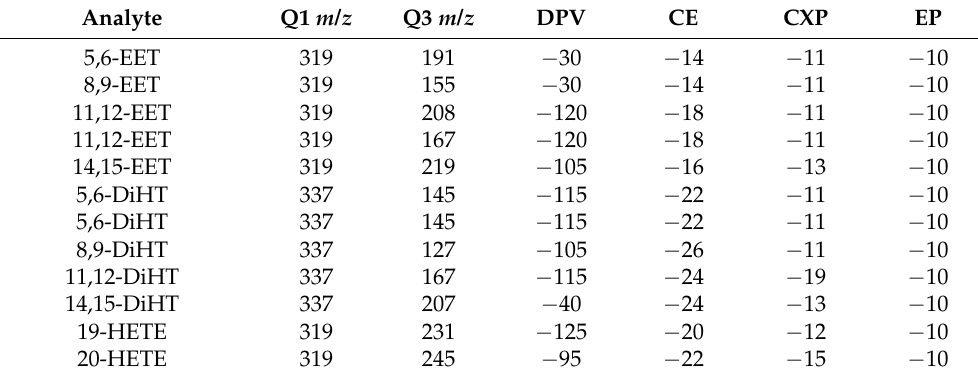
Table 3. Compound parameters for ArA metabolites and the deuterated IS with MRM in negative electrospray ionization mode are given